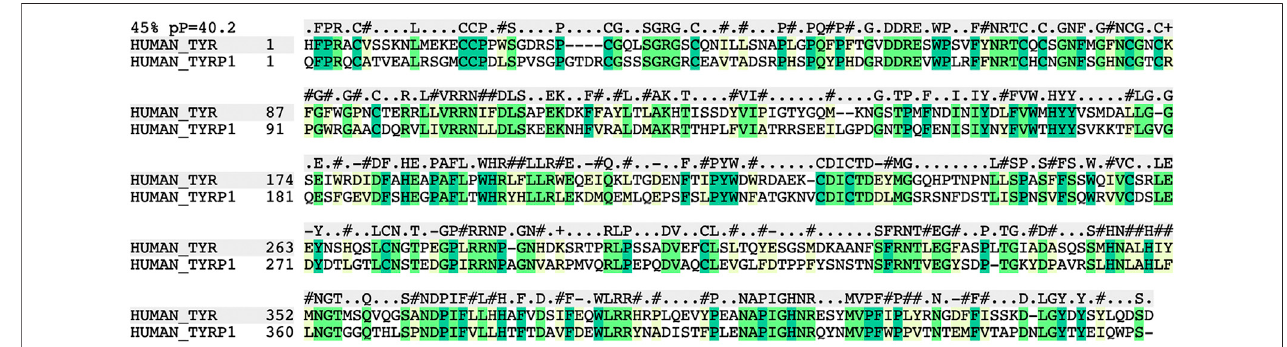
FIGURE 1 | Global Needleman and Wunsch sequence alignment between TYR and TYRP1 (PDB: 5m8n) showing 45% homology with a p -value ( p (cid:1) − log of pvalue) of 10 − 40.2 for structural similarity. Residues highlighted in green represent conserved residues. Residues highlighted in yellow represent non-identical but homologous residues, which are expected to have little to no effect on the overall structure of the